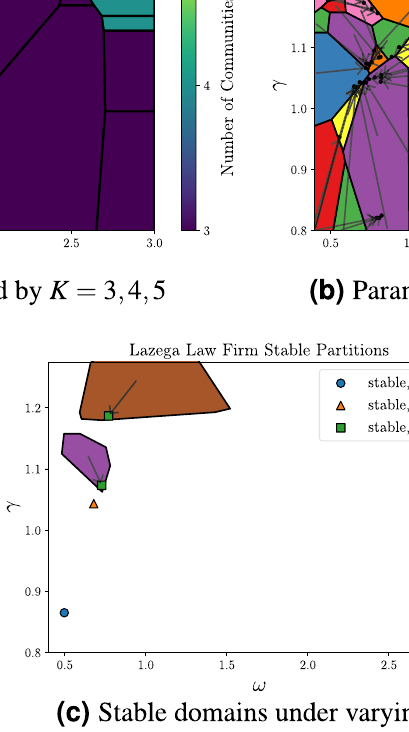
Figure 5. Results for the Lazega law firm multiplex network. ( a ) Domains of optimality for the partitions in CHAMP’s admissible subset. Color indicates number of communities. ( b ) Domains annotated with arrows to indicate each partition’s (ω , γ) parameter estimates. Partitions with identical communities across all layers, yielding an ω = ∞ estimate, are visualized with arrows to ω = 3 . ( c ) The domains and parameter estimates for the three stable partitions allowing K to vary, with additional points indicating other stable partitions found when separately fixing K = 2, 3, 4 prior to running CHAMP.